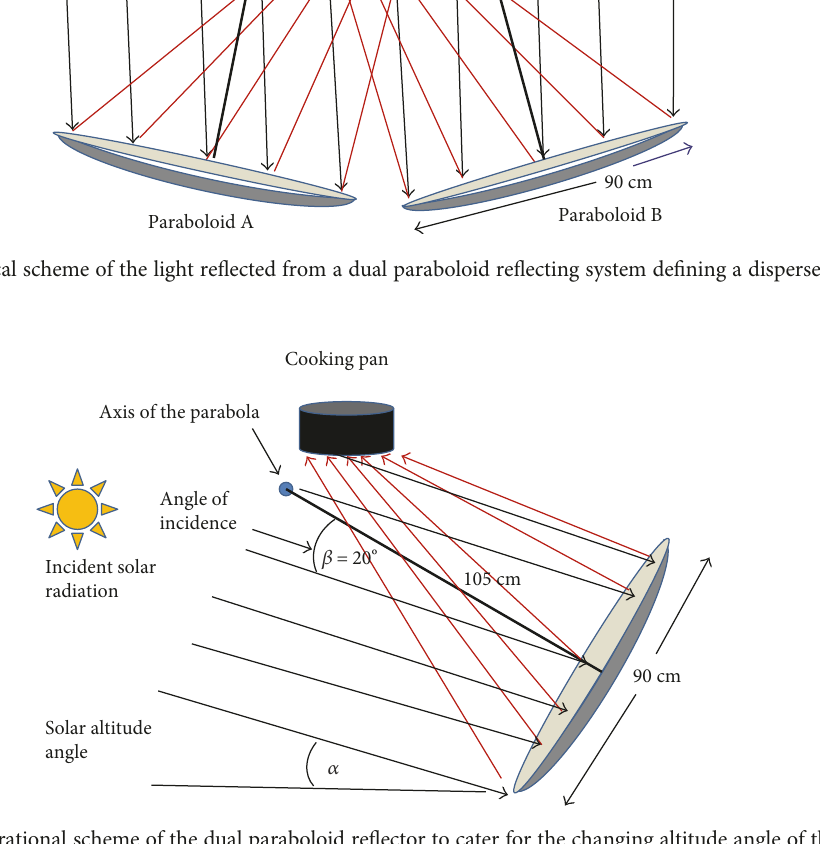
Figure 2: Operational scheme of the dual paraboloid re fl ector to cater for the changing altitude angle of the sun.